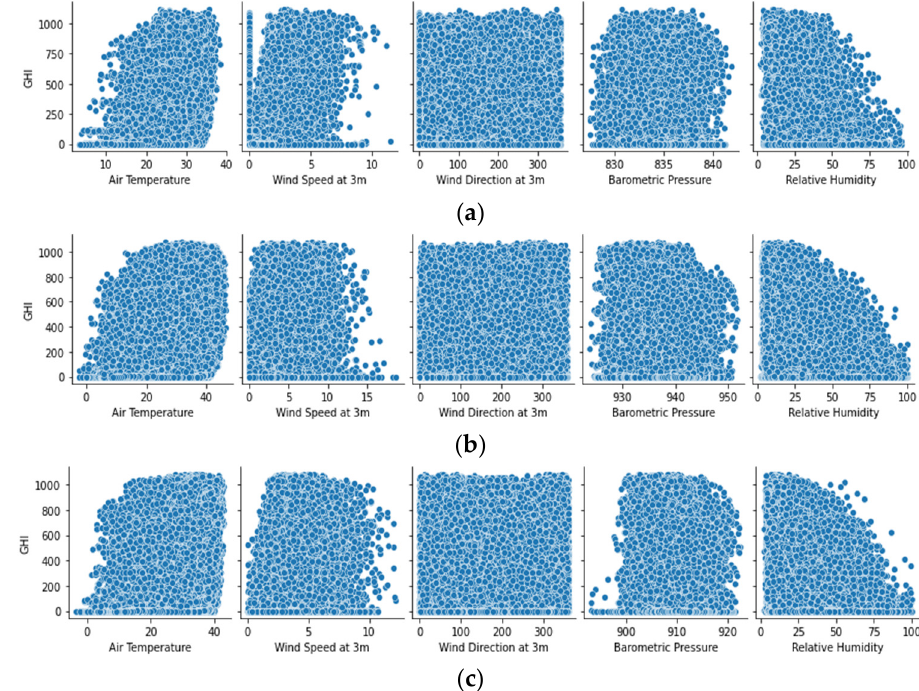
Figure 7. The relationship between GHI and the meteorological variables in: ( a ) Al-Baha; ( b ) Al-Jouf; and ( c ) Hail.